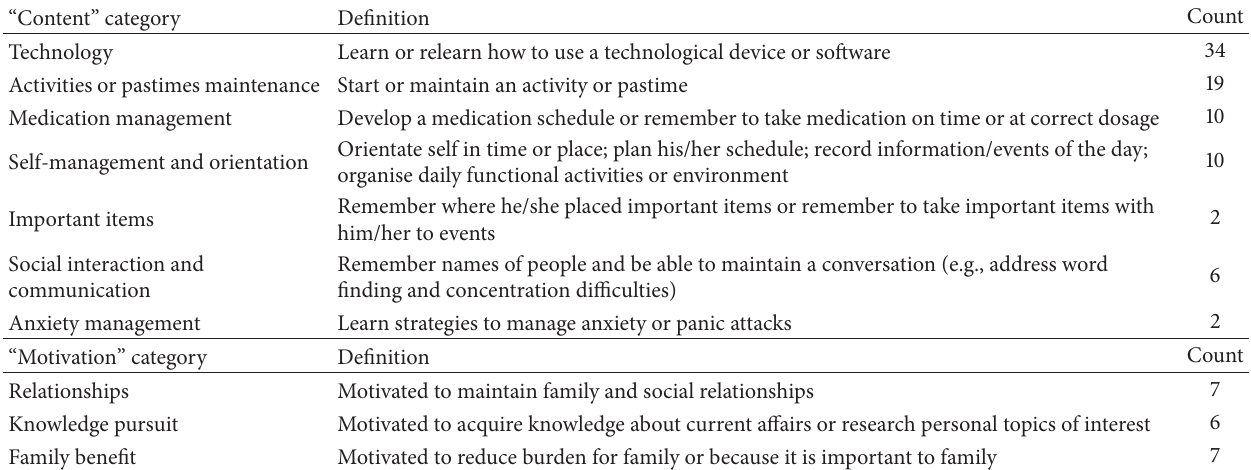
Table 3: Categories of goal